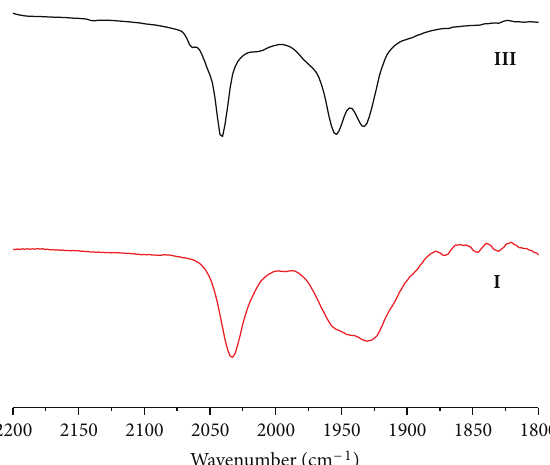
F 3: FTIR spectra of complexes III (black line) and I (red line) Cl at room temperature, with CaF in CH 2 2